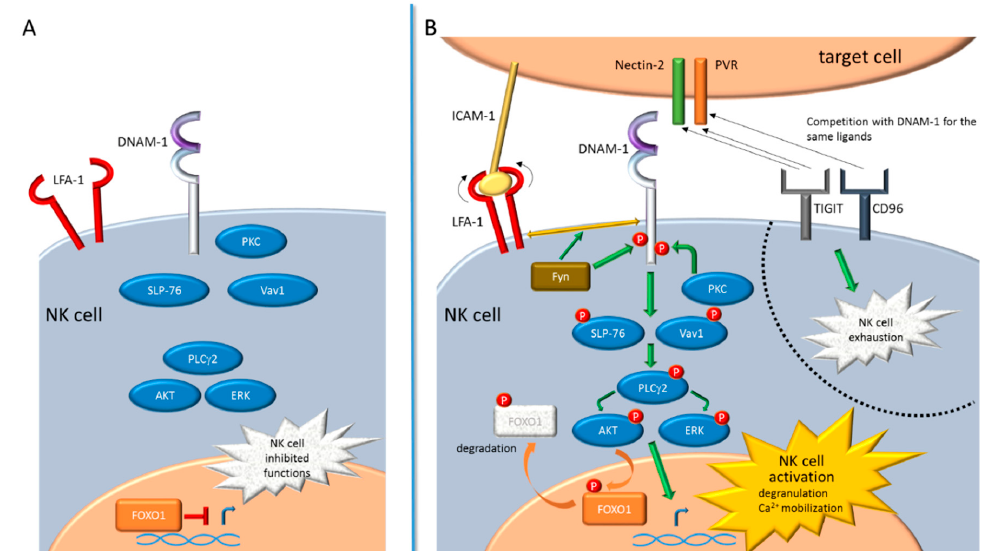
Figure 1. DNAM-1 signaling pathway leading to natural killer (NK) cell activation. ( A ) NK cell, not interacting with target cell, is not functional. FOXO1 negatively controls, at transcriptional level, many NK cell effector functions, including the cell homing and late-stage maturation. ( B ) When the immunological synapse is established between a NK cell and a target cell, several activating signal pathways trigger NK cell activation, including those mediated by DNAM-1. Upon the engagement of DNAM-1 with Nectin-2 or PVR activating ligands, expressed on the target cell, PKC phosphorylates the cytoplasmic domain of DNAM-1. At the same time ICAM-1, expressed on the target cell, binds LFA-1; thus promoting its conformational change; the recruitment of Fyn that phosphorylates the DNAM-1 cytoplasmic domain; and, as a consequence, the association of DNAM-1 with LFA-1. The DNAM-1 downstream signaling cascade leads to the phosphorylation of SLP-76 and Vav1, that induce the activation of PLC γ 2 and, downstream, of ERK and AKT. This DNAM-1-dependent signaling cascade promotes the expression of genes involved in the degranulation and calcium (Ca 2+ ) mobilization, leading to the NK cell activation. Activated AKT phosphorylates FOXO1, thus mediating the FOXO1 translocation from the nucleus to the cytoplasm, where it is degraded and inactivated. The expression of the immune checkpoint molecules TIGIT and CD96 renders NK cell functionally exhausted, since both receptors compete with DNAM-1 for the binding to the same activating ligands (indicated by black arrows).